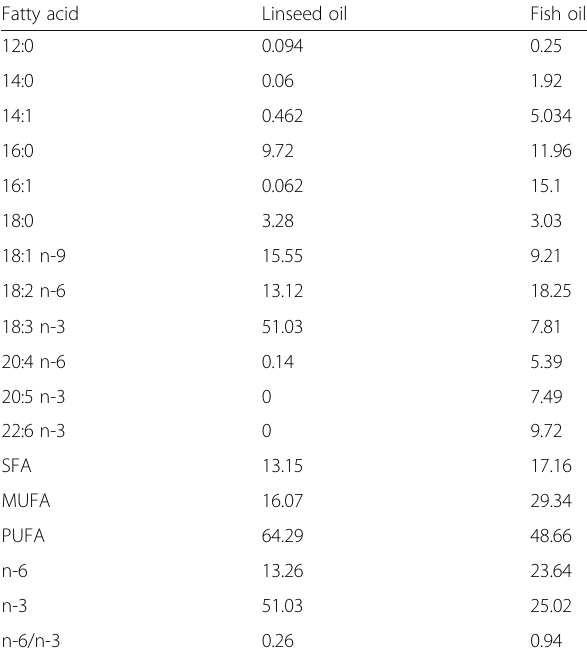
Table 2 Fatty acids composition (as g/100 g fatty acids) of the supplemental